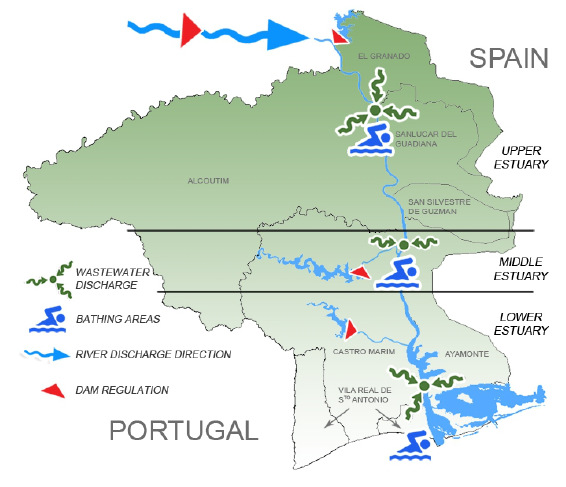
Fig. 3 . Guadiana Estuary Virtual System. The bathing areas identified on the map include both the designated and non- designated